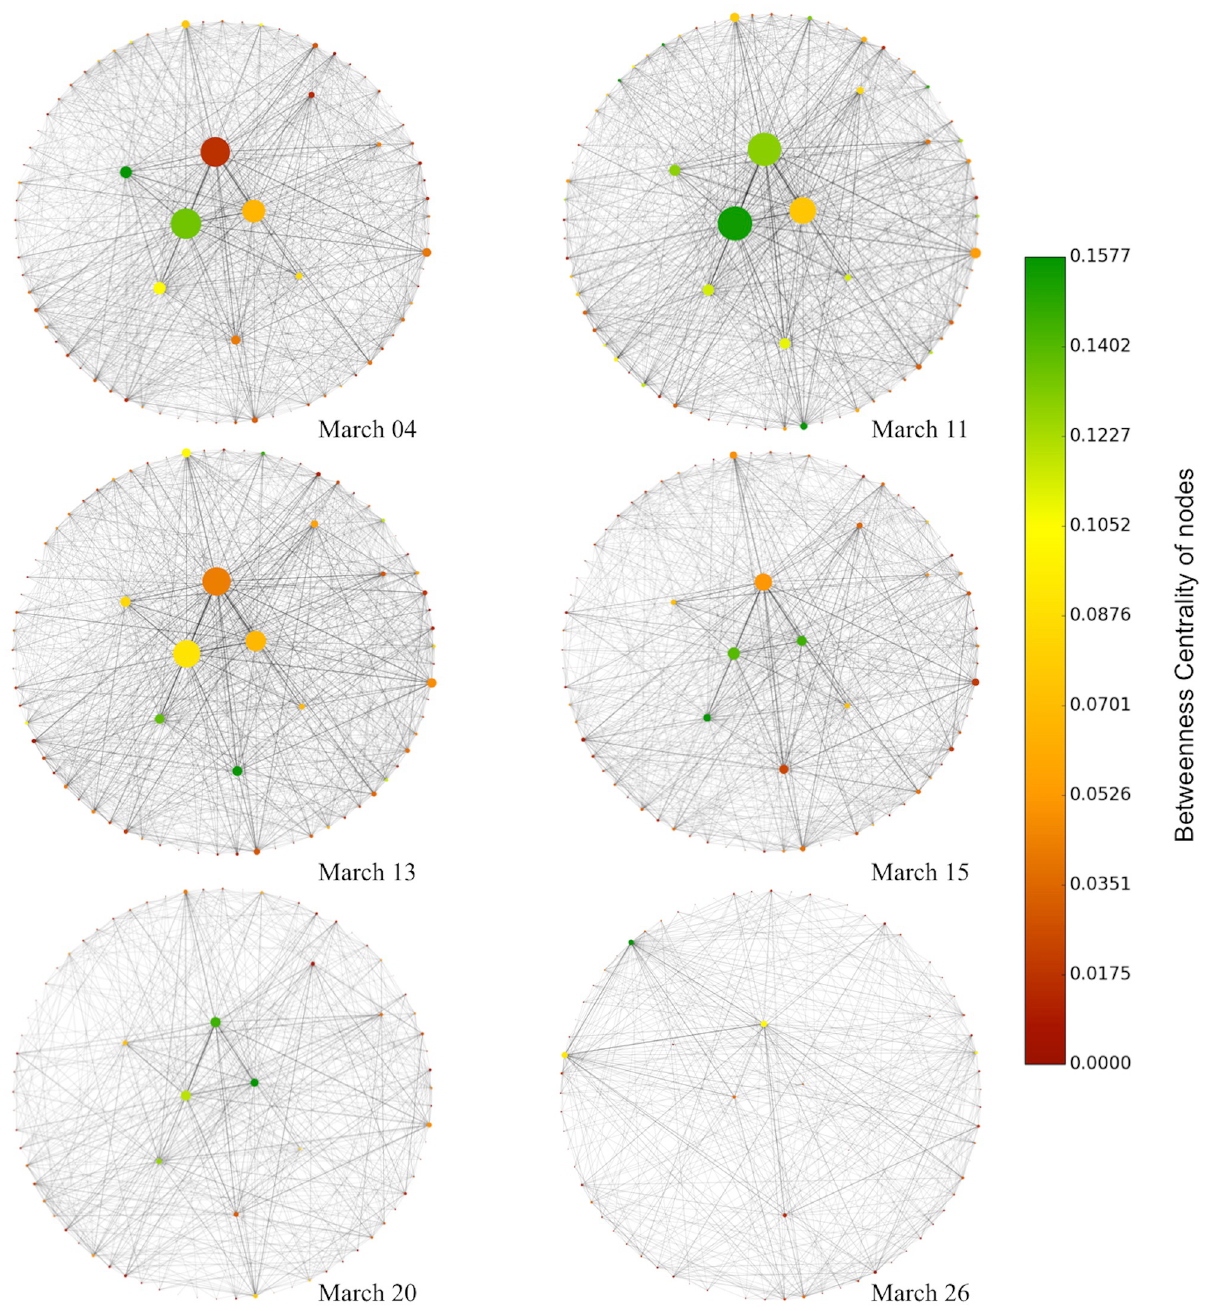
Fig 5. The color of the nodes (Chicago community areas) is proportional to the weighted betweenness centrality. The size of the nodes is proportional to the strength of the nodes (community areas) (log10 transformed).